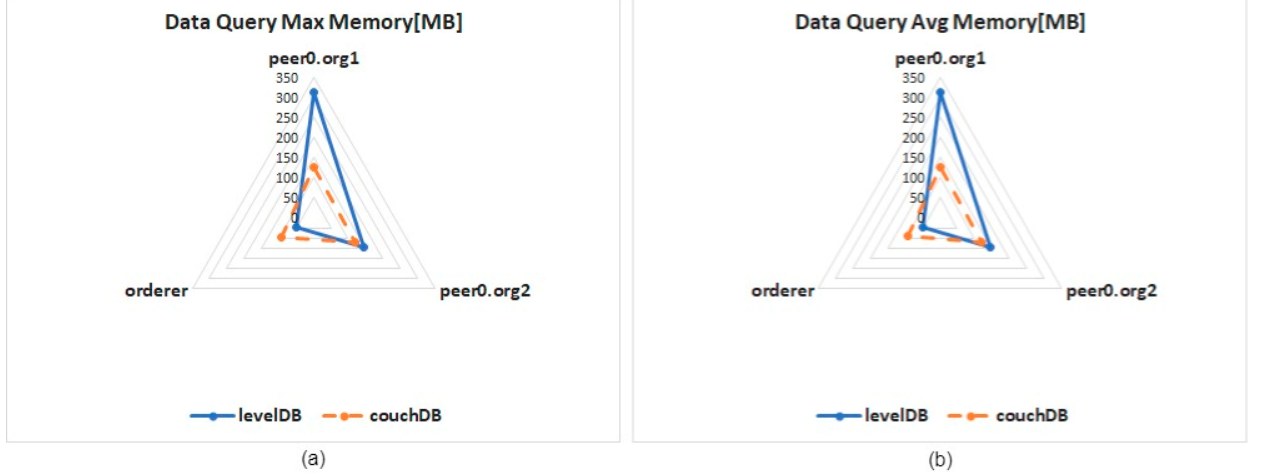
Figure 14. Memory usage for single data query: ( a ) maximum memory usage, ( b ) average memory usage.